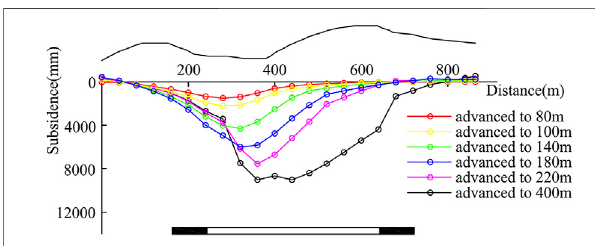
FIGURE 10 | Surface subsidence